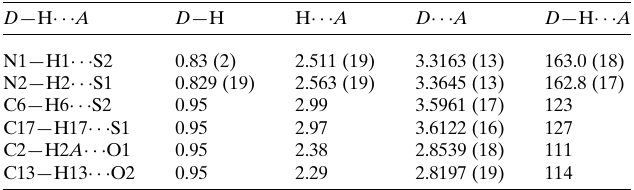
Table 4 Hydrogen-bond geometry (A˚ , (cid:5) ) for (IV).